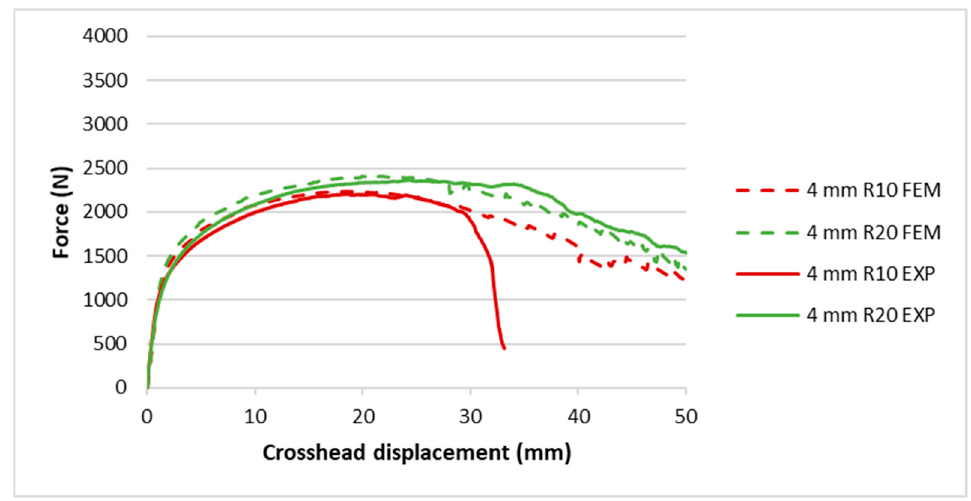
tween the force and the cross-head displacement for 4.5 mm sheet.